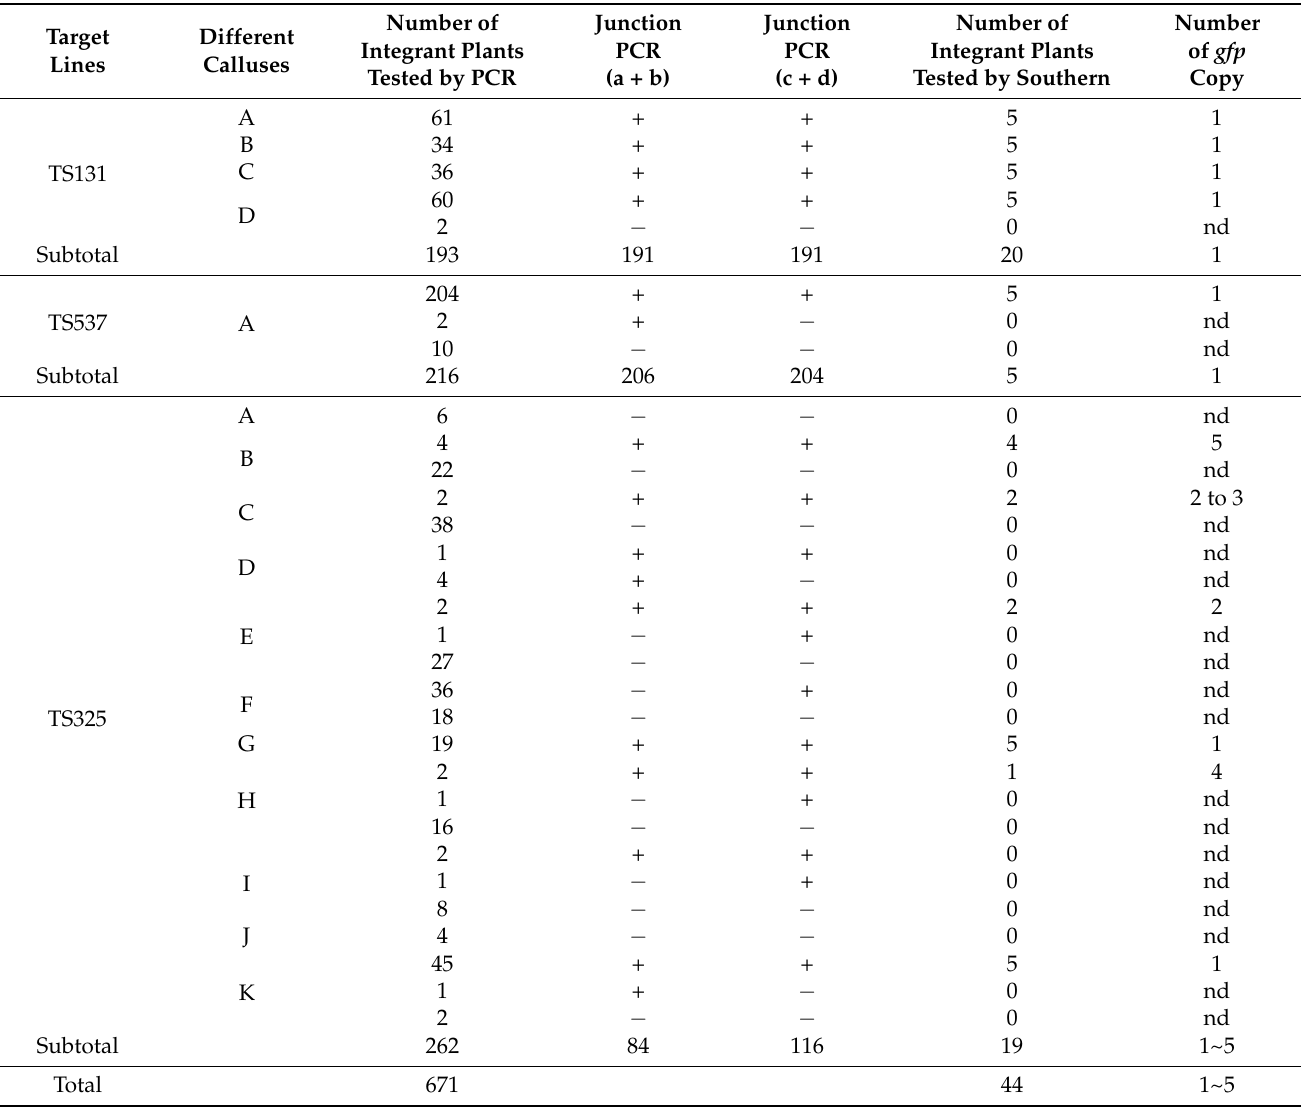
Table 2. PCR and Southern detection of rice plants with type I site-specific